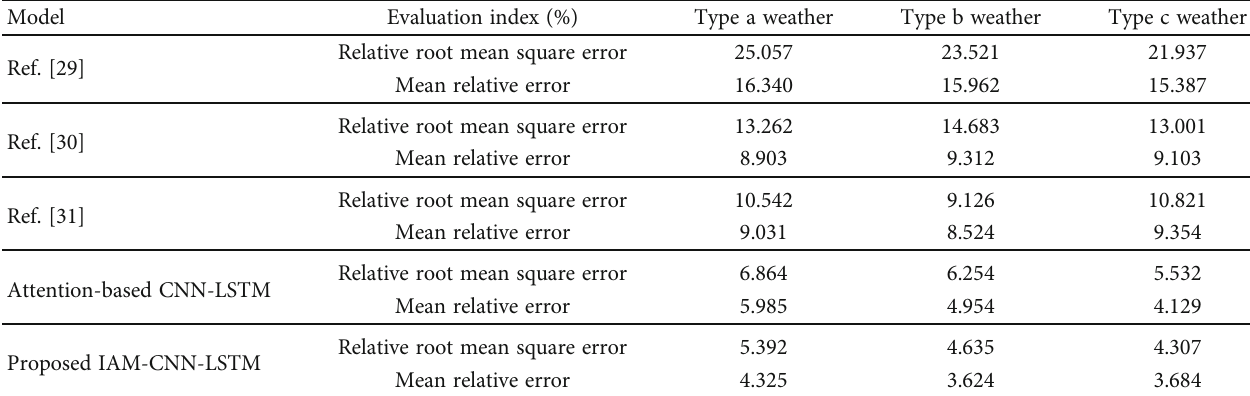
Table 4: Comparison of the proposed and existing